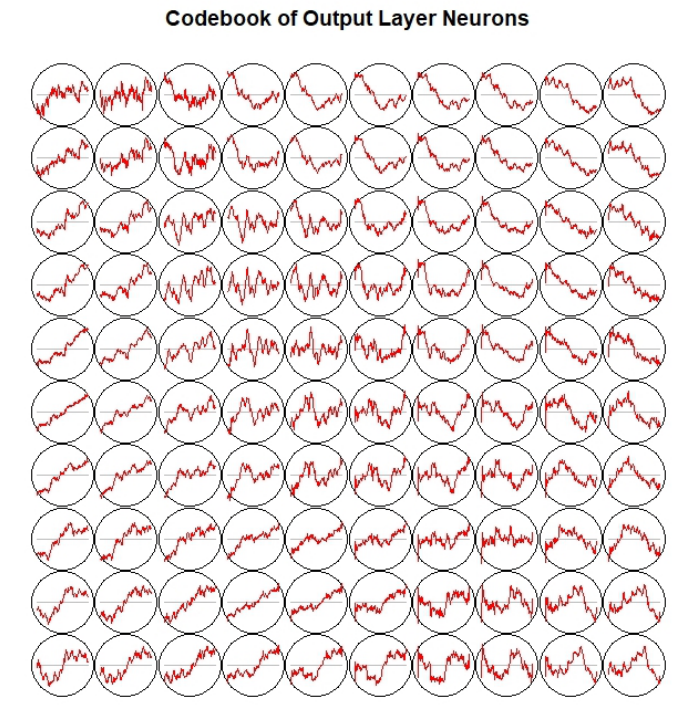
Figure 9. Codebook of SOM